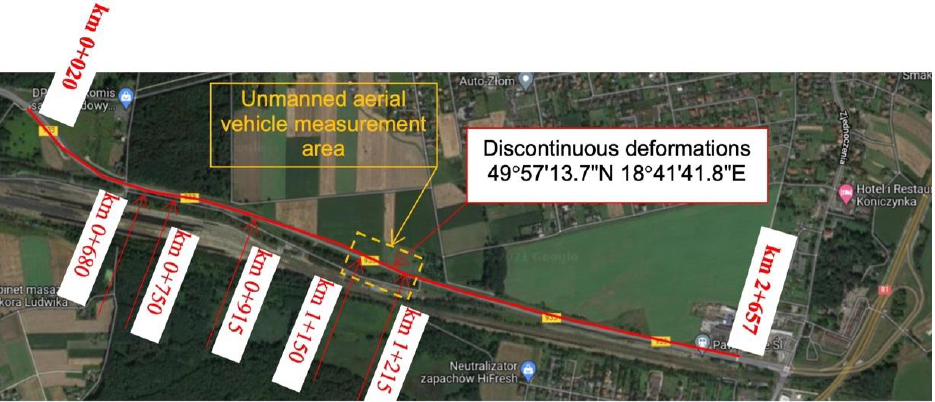
Figure 3. Location of the tested road section.